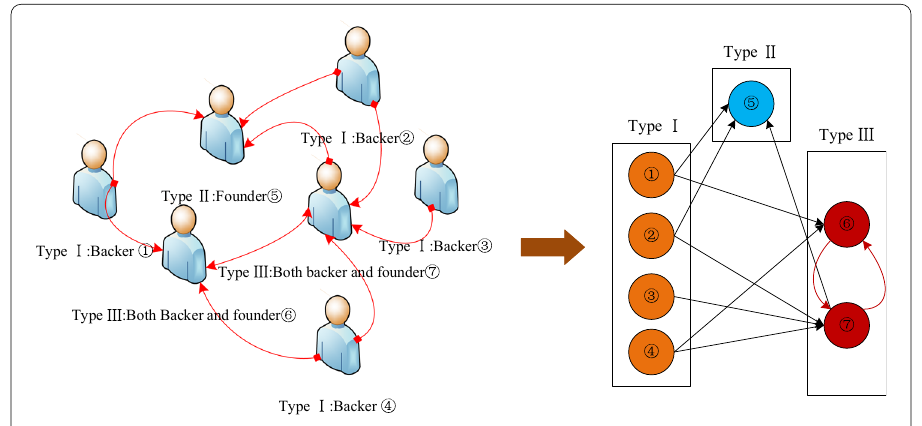
Fig. 3 Internal social connection network